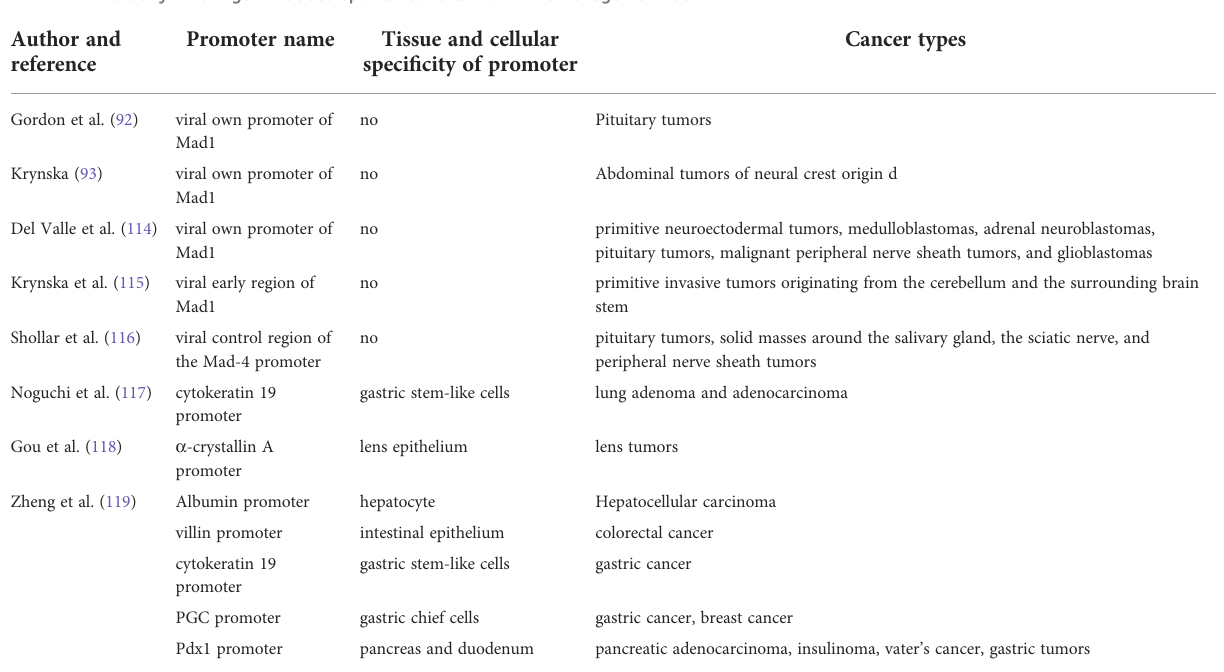
TABLE 1 The JCPyV T antigen-induced spontaneous tumor in the transgenic